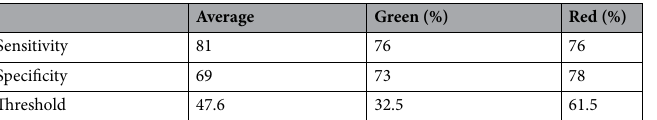
Table 1. Sensitivity, specificity and threshold values of the MMAT diagnostic test regarding the average foot sole hydration and, the green pixels and red pixels